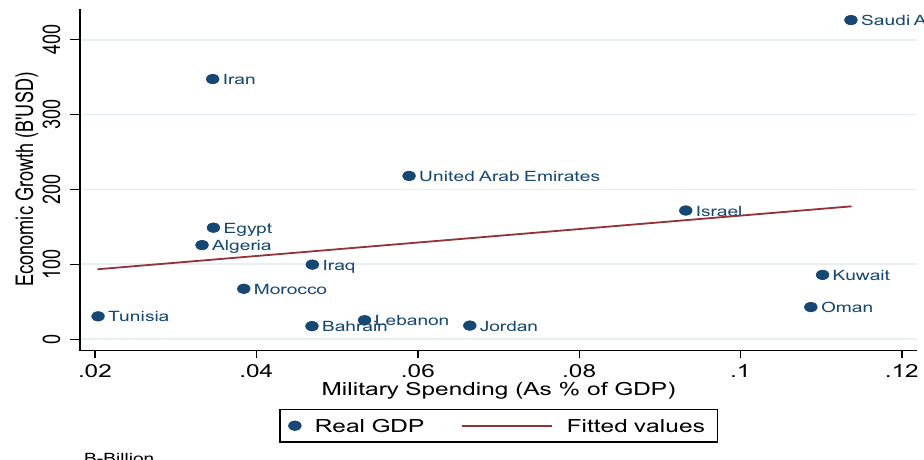
Fig. 6 Real GDP and military burden in selected MENA countries